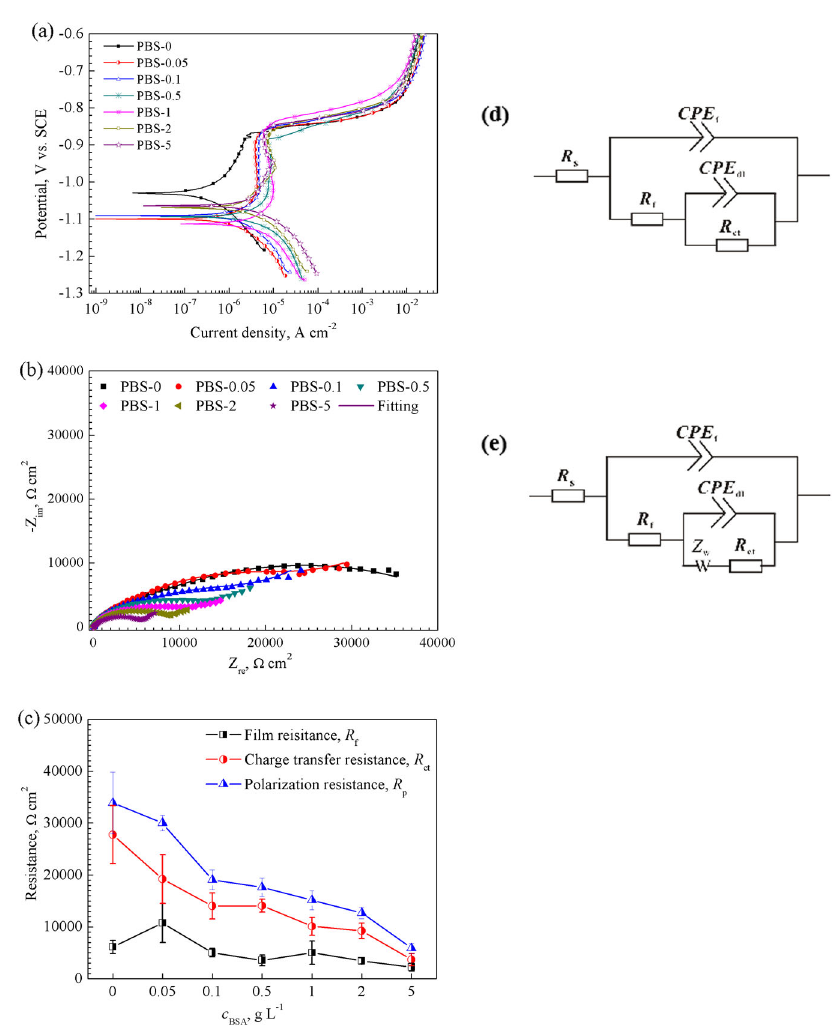
Fig. 1 a Potentiodynamic polarization curves and b Nyquist plots of pure Zn in PBS containing BSA of 0 g L − 1